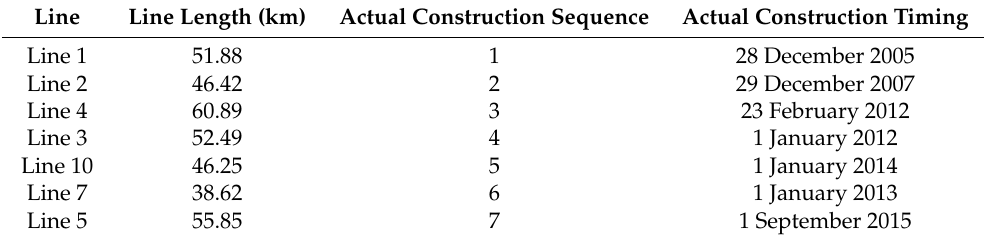
Table 4. Construction schedule of the seven metro lines used in this case study.